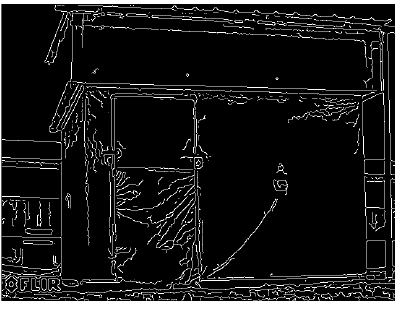
Figure 5: Infrared image of the test module